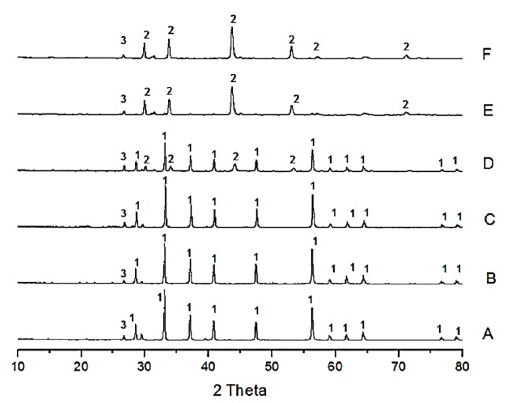
Figure 2. XRD of the samples treated in the N pyrite; 2) pyrrhotite; 3) quartz.